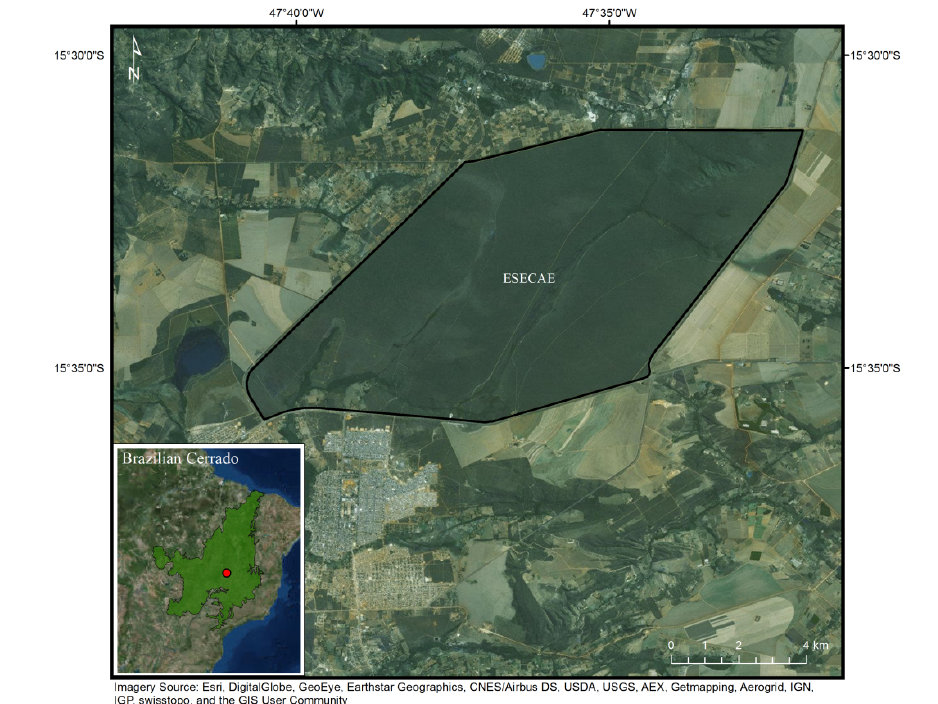
Figure 4. Study area in the Brazilian Cerrado: Estação Ecológica de Águas Emendadas (ESECAE).